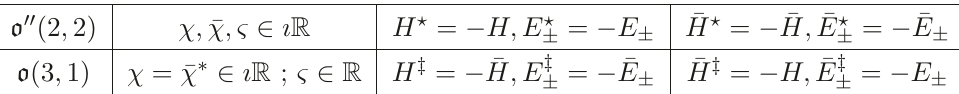
Table 3 . Real quantizations of r II ( χ, ¯ χ, ς ) = χ E + ∧ H + ¯ χ ¯ E + ∧ ¯ H + ςE + ∧ ¯ E + . where Σ 0 = Σ, Σ 1 = ¯Σ and Σ k +1 is denoted with index mod 2, i.e. Σ k +1 is equal to Σ 0